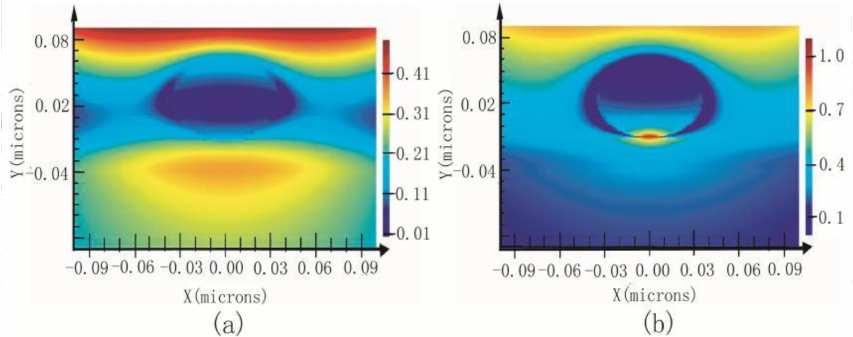
Figure 3. Electromagnetic field between 70 nm gold nanoparticles and different substrates; ( a ) silicon, ( b )